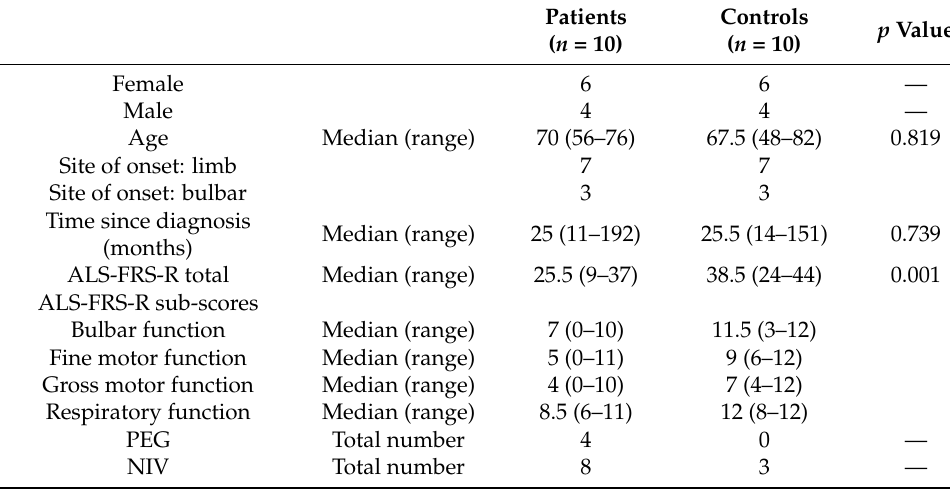
Table 1. Characteristics of patients and controls.